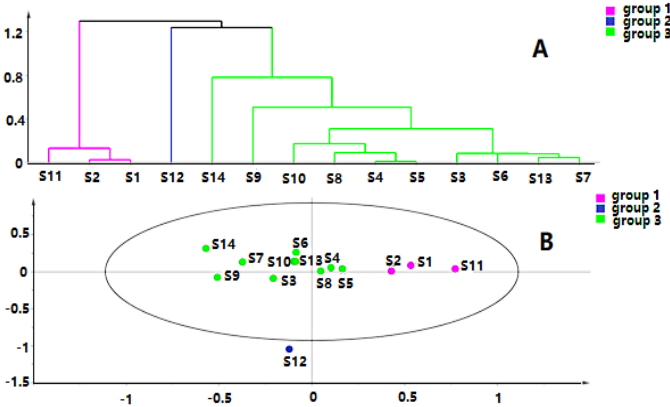
Figure 5. HCA ( A ) and principal component analysis (PCA) ( B ) of Cortex Periplocae from different producing areas.